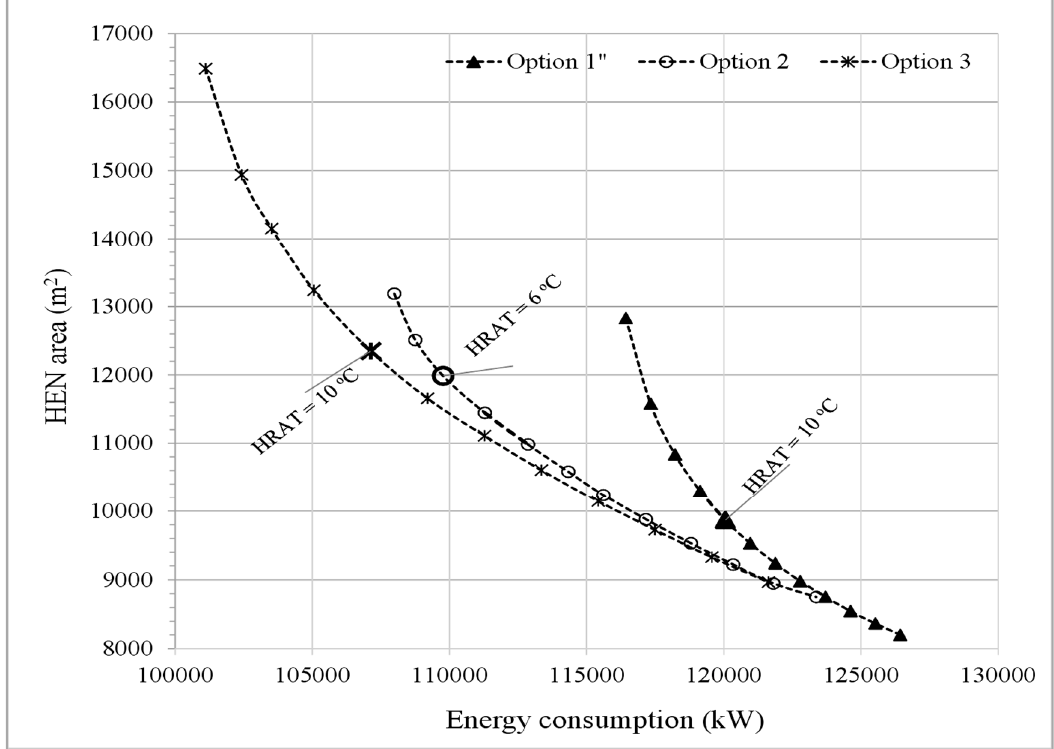
Figure 5. Energy consumption profile with heat transfer area for the three options.